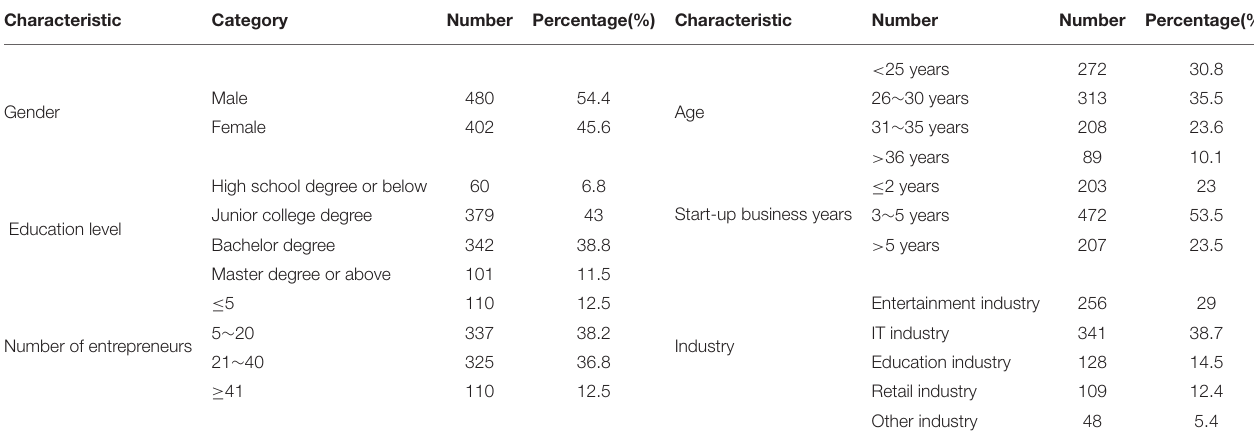
TABLE 1 | Descriptive characteristics of samples ( N =